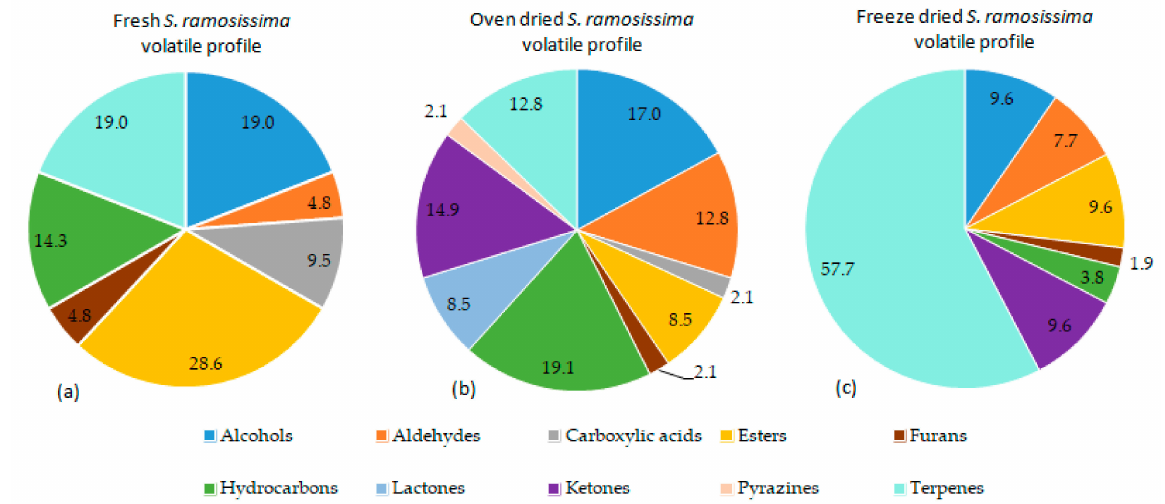
Figure 2. Pie charts showing the chemical classes profile of volatile compounds of the S. ramosissima . ( a ) Volatile com- pounds profile of fresh plant; ( b ) volatile compounds profile of oven-dried plant; and ( c ) volatile compounds profile of freeze-dried